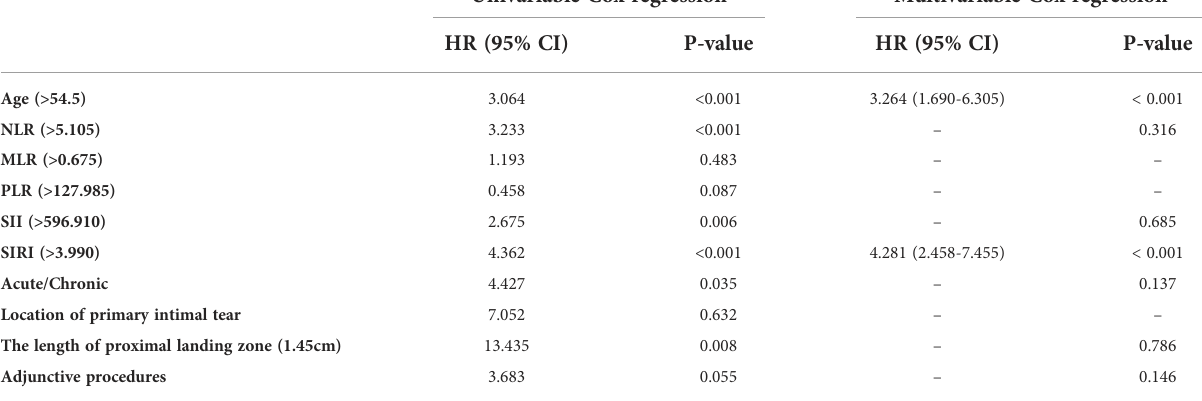
TABLE 3 Cox regression analysis.